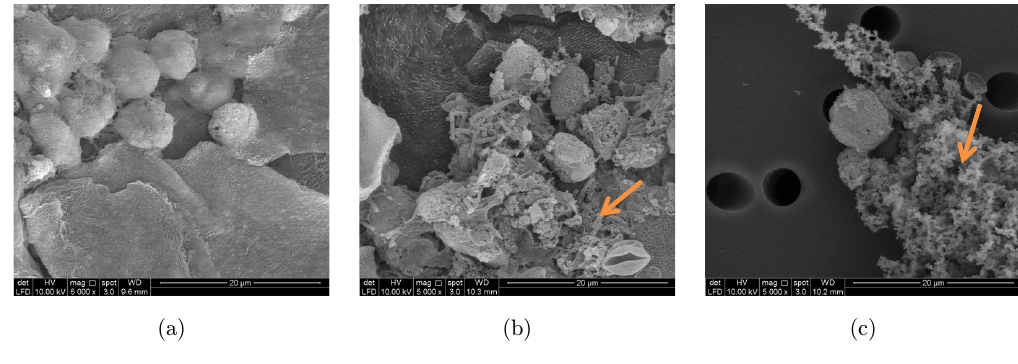
Fig. 1. Display of cervical cells samples: (a) Normal, (b) LSIL, and (c) HSIL FE-SEM images.